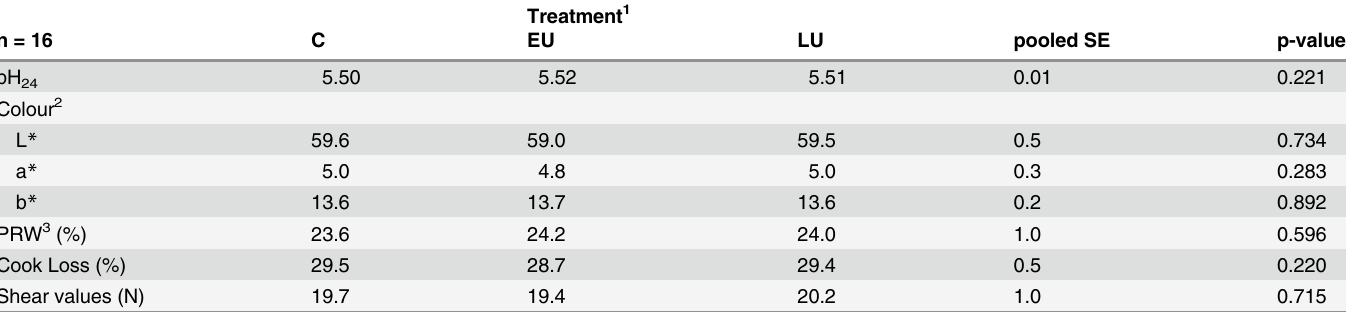
Table 4. Effect of gestational maternal undernutrition on L . lumborum muscle meat quality characteristics of rabbit offsprings (n =